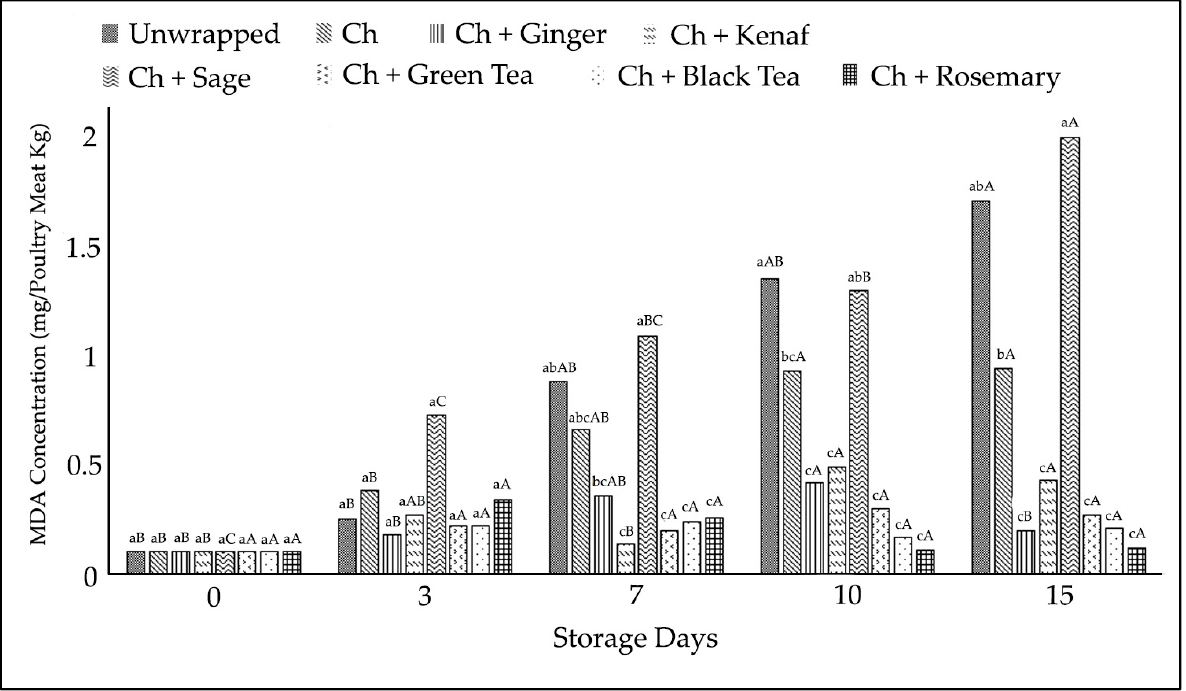
Figure 2. Lipid oxidation of the meat over refrigerated storage. a–c: Different letters indicate significant differences between treatments ( p < 0.05). A–C: Different letters indicate significant differences between storage time ( p < 0.05). Ch: Chitosan; MDA: